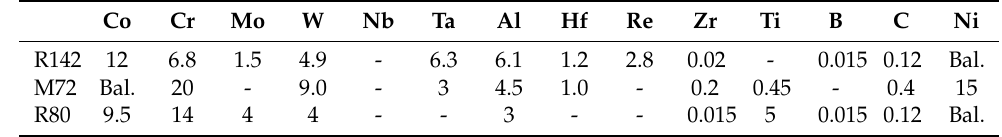
Table 2. Chemical composition of materials used in this work in